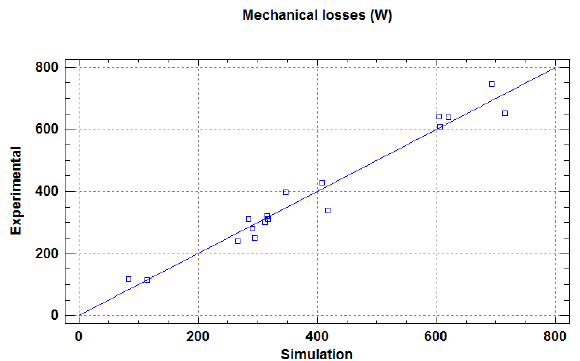
Figure 9. Validation of mechanical losses.